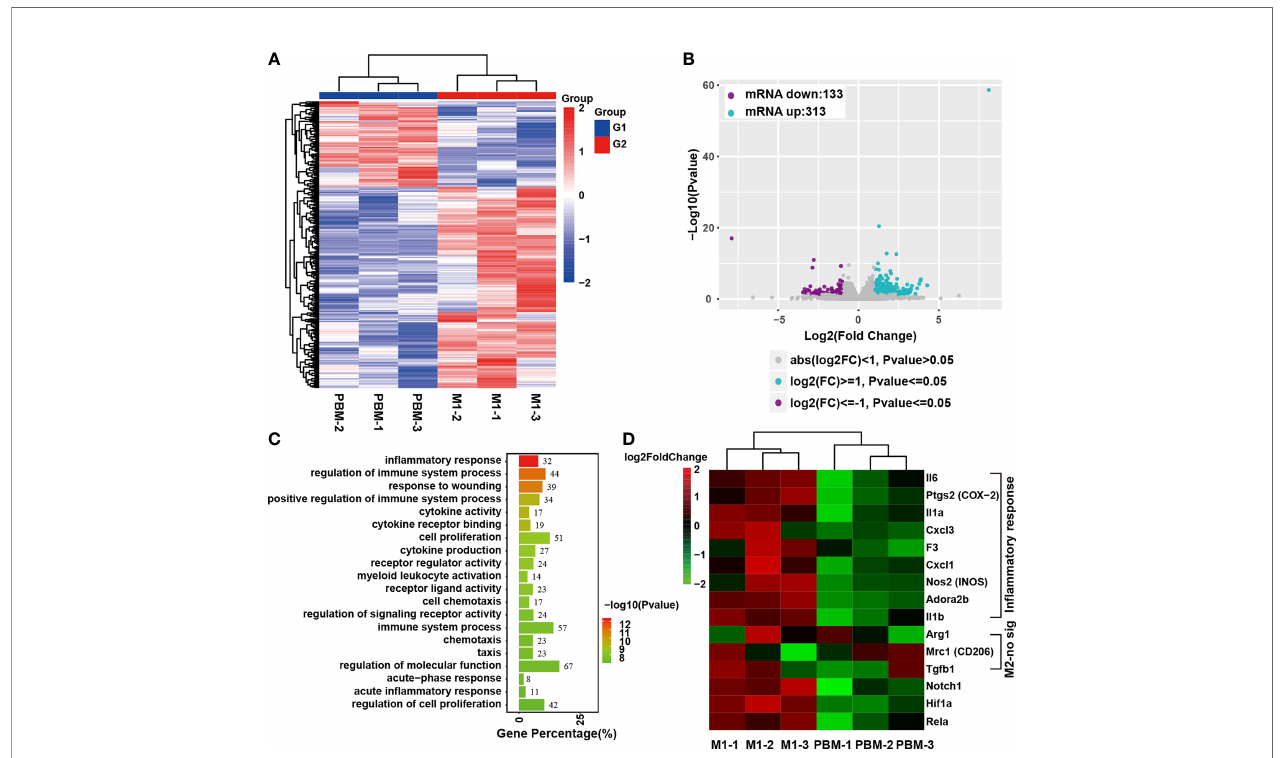
FIGURE 4 | Transcriptome analysis of the effect of PBM on M1 macrophages. (A, B) There were 446 genes that were signi fi cantly altered, with 313 upregulated and 133 downregulated. (C) GO analysis of the differentially expressed genes (DEGs). (D) Heatmap of DEGs associated with in fl ammatory responses in macrophages. The heatmap shows that Notch1 and HIF-1 a are downregulated genes related to in fl ammation regulation. IL-6, PTGS2 (COX-2), and IL-1 a were the three genes with the largest fold differences among the in fl ammatory response-related DEGs, with p values less than 0.01 (this experiment was independently repeated three